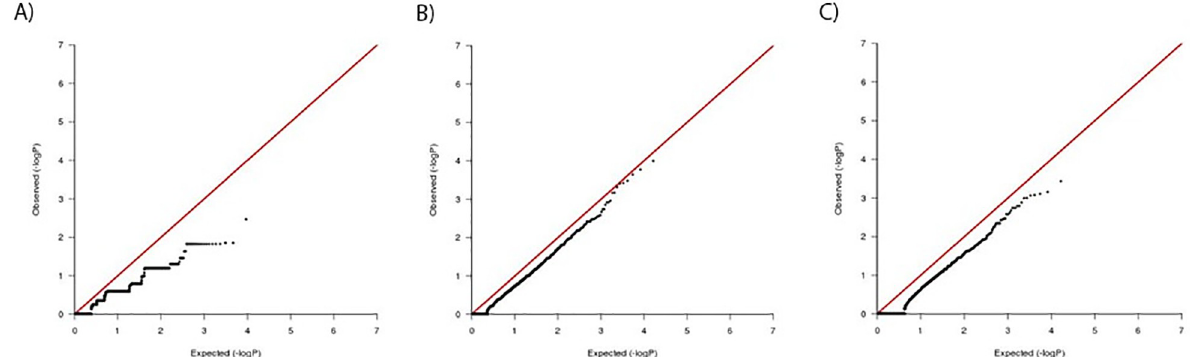
Fig 6. Results of gene-based collapsing analysis of CZP responder and non-responder exome sequencing data. (A) QQ plot of observed vs null FET significance values for CZP super-responders vs non-responders. (B) CZP super-responders are compared to sequence data from 1546 population controls and 55 non-responders, while C shows QQ plot of CZP non-responders compared to 1546 population controls and 19 super- responders. In all three analyses, no individual genes exceeded what was expected under the null hypothesis. https://doi.org/10.1371/journal.pone.0261165.g006 Table 5. Top ten most strongly associated individual variants from whole exome sequencing. Variant Gene